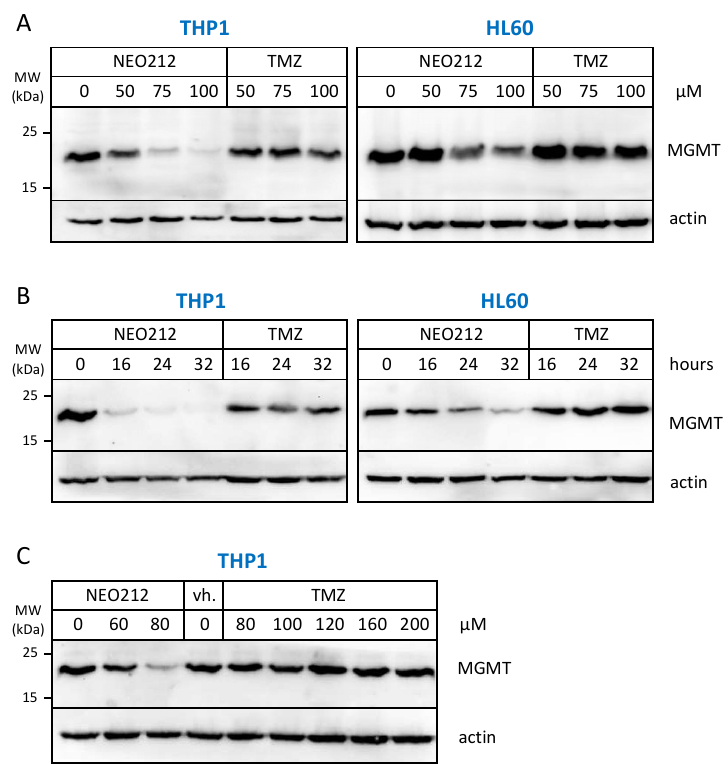
Figure 4. NEO212 treatment down-regulates MGMT protein levels. THP1 and HL60 cells were exposed to NEO212 or TMZ, and MGMT protein levels were determined by Western blot. ( A ) Cells treated with increasing drug concentrations were harvested after 24 h. ( B ) Cells treated with 80 µM of either drug were harvested at different time points thereafter. ( C ) Cells treated with increasing drug concentrations were harvested after 24 h. Original blots see File S1.